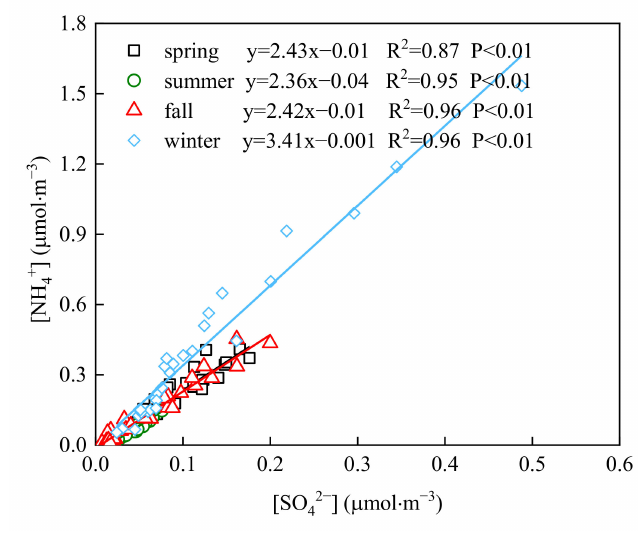
Figure 5. Correlations between [NH 4+ ] and [SO 42 − ].